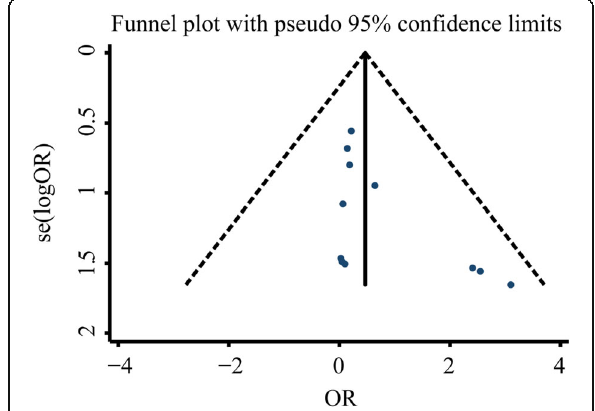
Fig. 8 Inverted funnel plots of bias analysis on recurrence